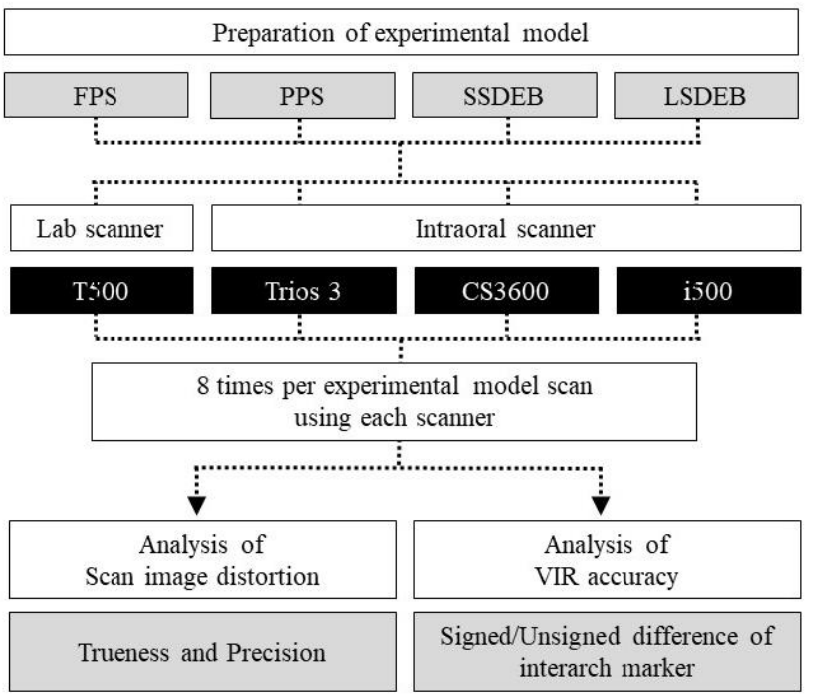
Figure 1. Workflow of the study. FPS: Full Posterior Support; PPS: Partial Posterior Support; SSDEB: Short Span Distal Extension Base; LSDEB: Long Span Distal Extension Base; VIR: Virtual Interocclusal Record.